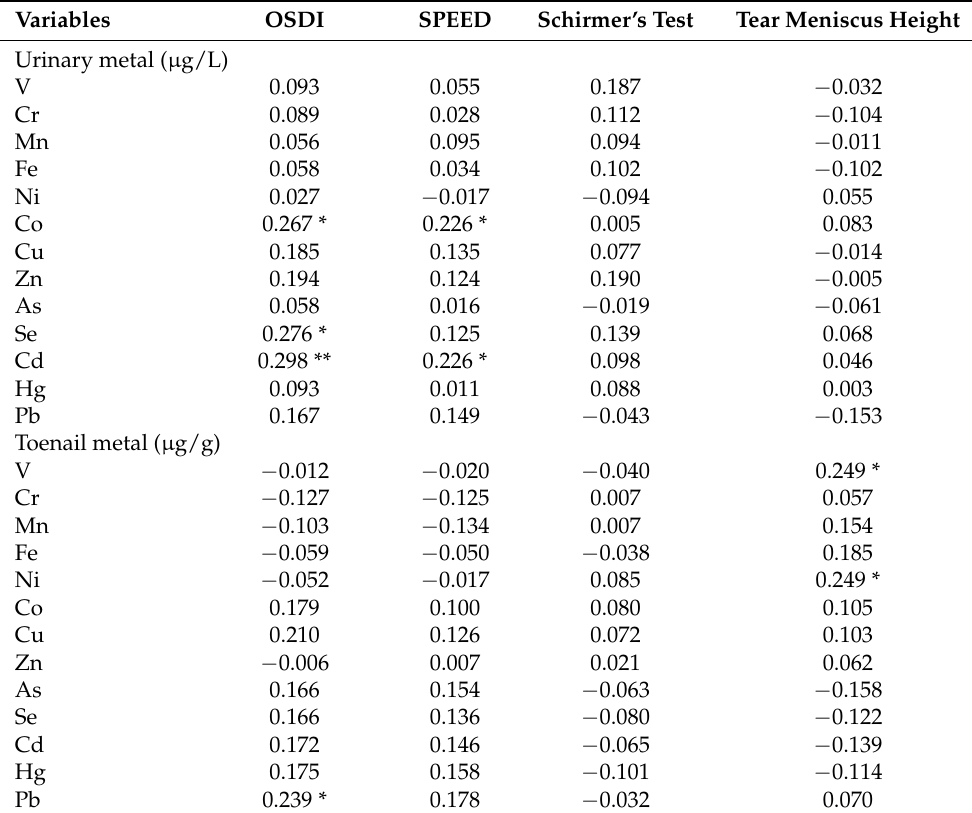
Table 4. Correlational coefficients among metal biomarkers and dry eye metrics a